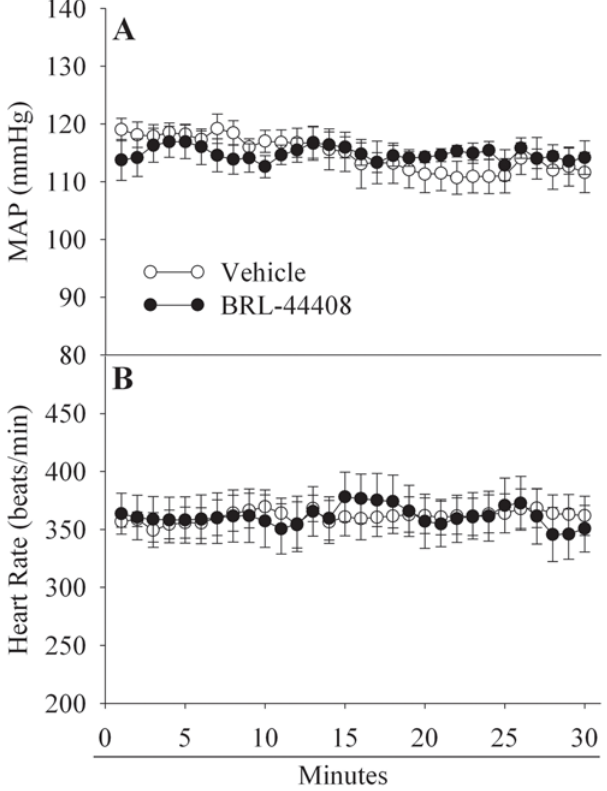
Figure 9. BRL-44408 has no effects on MAP and heart rates in normal rats. Effects of a 2A -AR inhibitor BRL-44408 on mean arterial pressure (MAP, A ) and heart rates ( B ) in normal rats. Normal rats received either Vehicle treatment or BRL-44408 maleate iv 2.5 mg/kg BW over a period of 30 min. Data are presented as mean 6 SE (n=5/ group), and compared by Student’s t -test. No statistical difference was found.